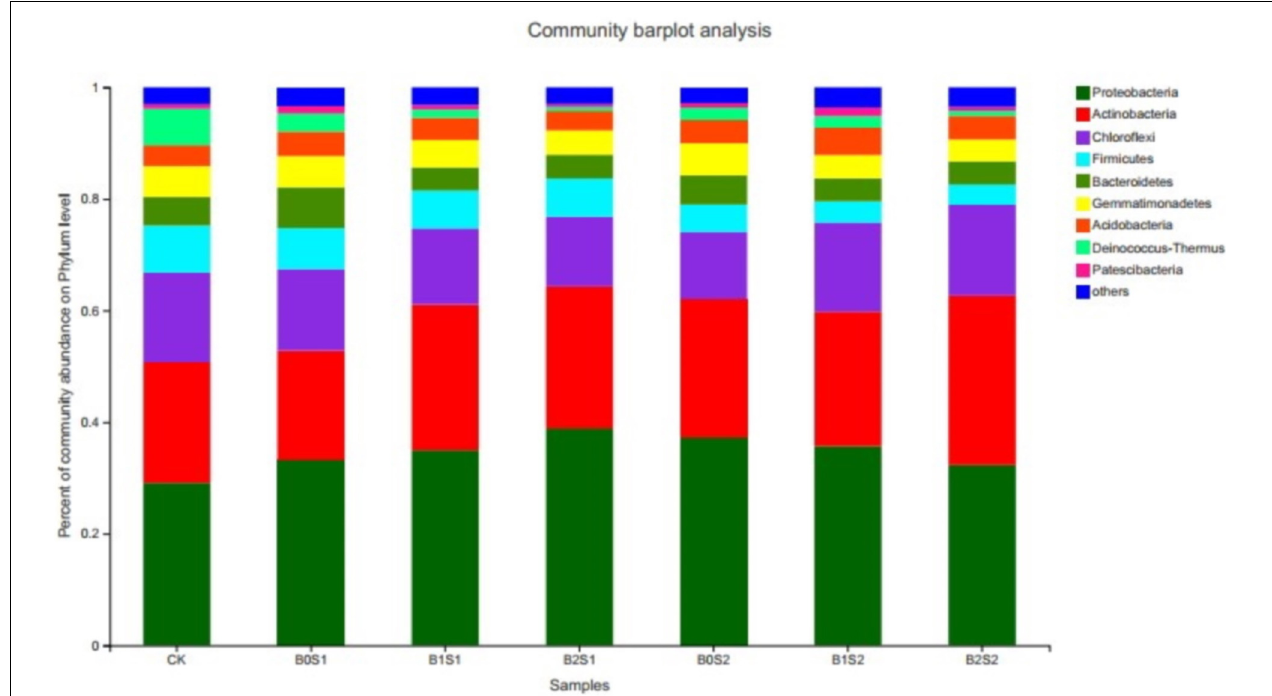
FIGURE 1 | Relative abundance of soil bacterial communities at phylum level. Data are presented mean; CK = control, B0S1, B1S1, B2S1, B0S2, B10S2, and B2S2 = 0, 15, and 30 g biochar + 0.5 and 1 g salt g kg − 1 , respectively.